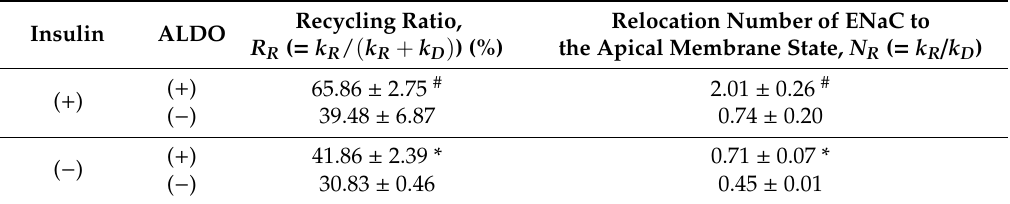
Table 2. The recycling ratio, k R ( = k R / ( k R + k D ) ) of ENaC and the relocation number how many times ENaC is relocated to the apical membrane state (Apical), N R ( = k R / k D ), after the first retrieval, in the presence and absence of 100 nM insulin with and without 1 µ M aldosterone treatment for 20 h. Recycling Ratio, Relocation Number of ENaC to Insulin ALDO R R ( = k R / ( k R + k D ) ) (%) the Apical Membrane State, N R ( = k R / k D ) ( + ) 65.86 ± 2.75 ( + )